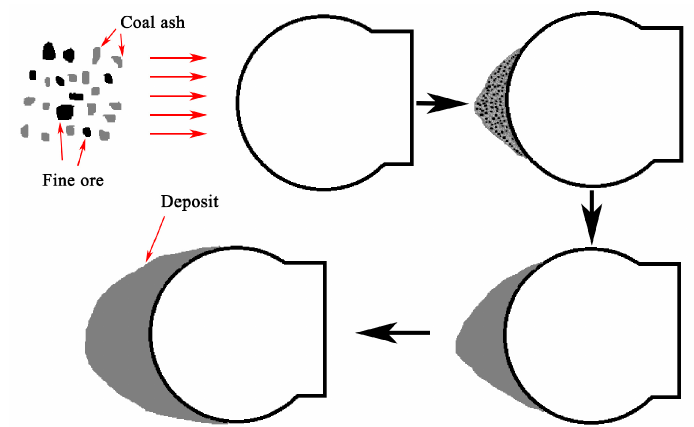
Figure 11. Impact deposition mechanism of air duct deposit.